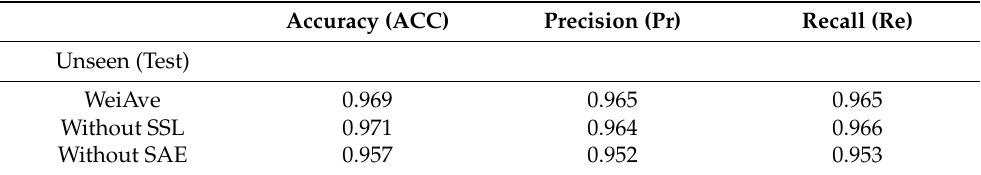
Table 5. Comparison of the classification performance of the proposed scheme with the one derived without the use of any SSL algorithm and without the SAE encoding.